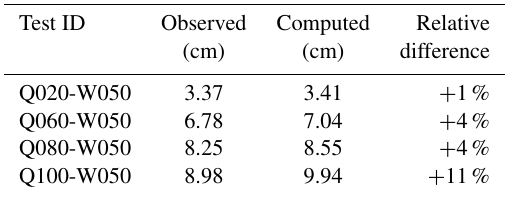
Table 2. District-averaged water depths for inflow discharges be- tween 20 and 100m 3 h − 1